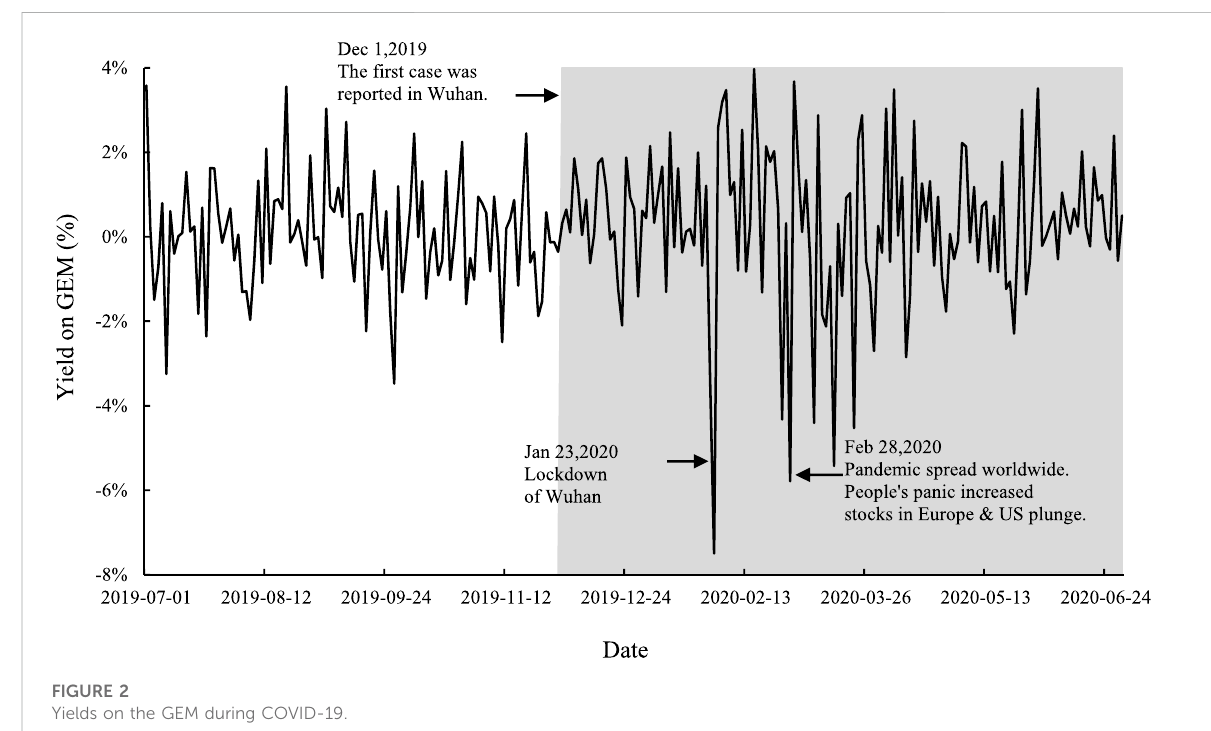
FIGURE 2 Yields on the GEM during COVID-19.